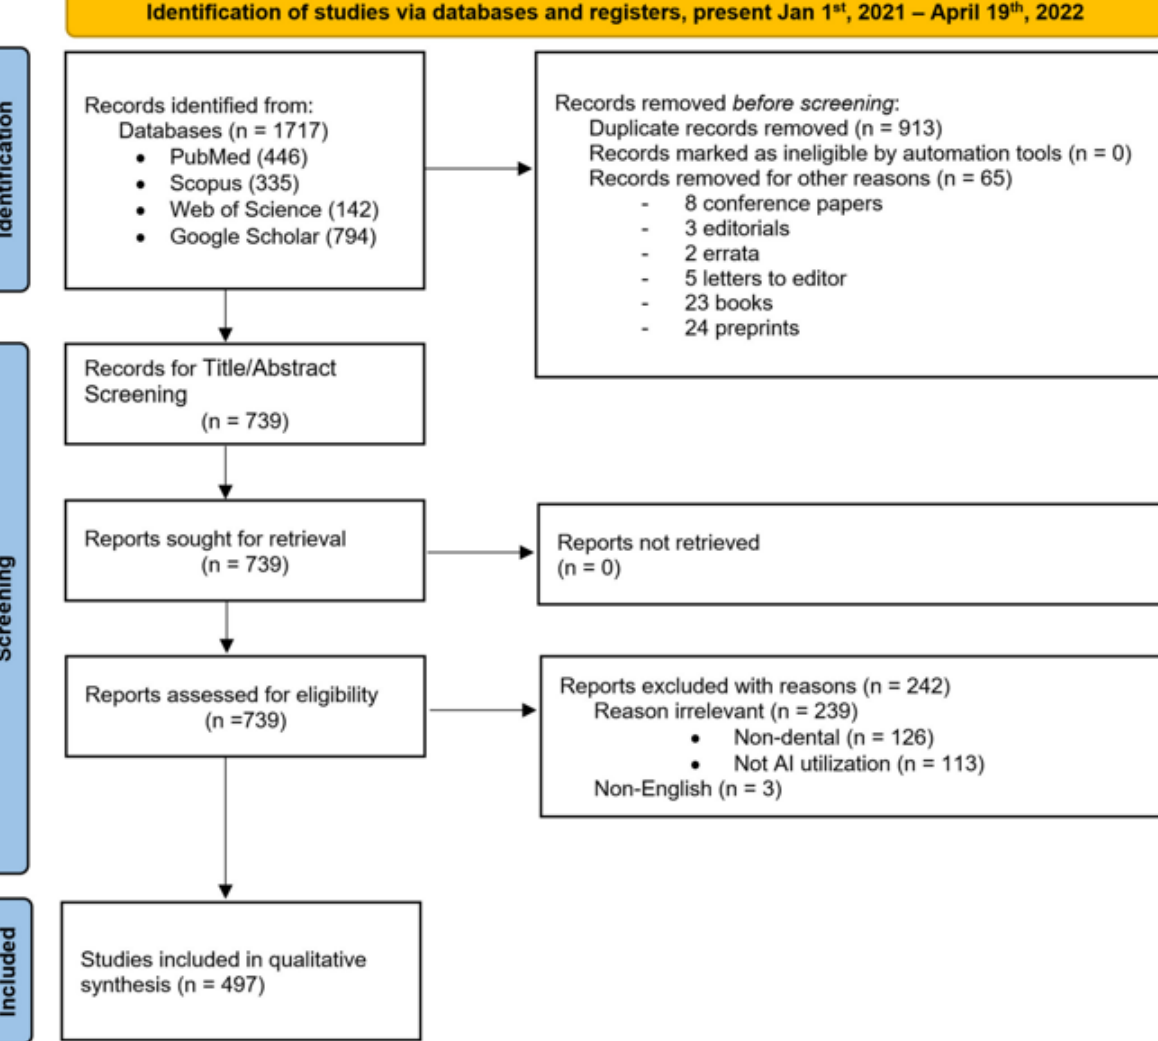
Figure 5. The PRISMA flow chart diagram depicts the flow of information through the different phases of a systematic review. It maps out the number of records identified, included, and excluded, and the reasons for exclusions. Different templates are available depending on the type of review (new or updated) and sources used to identify